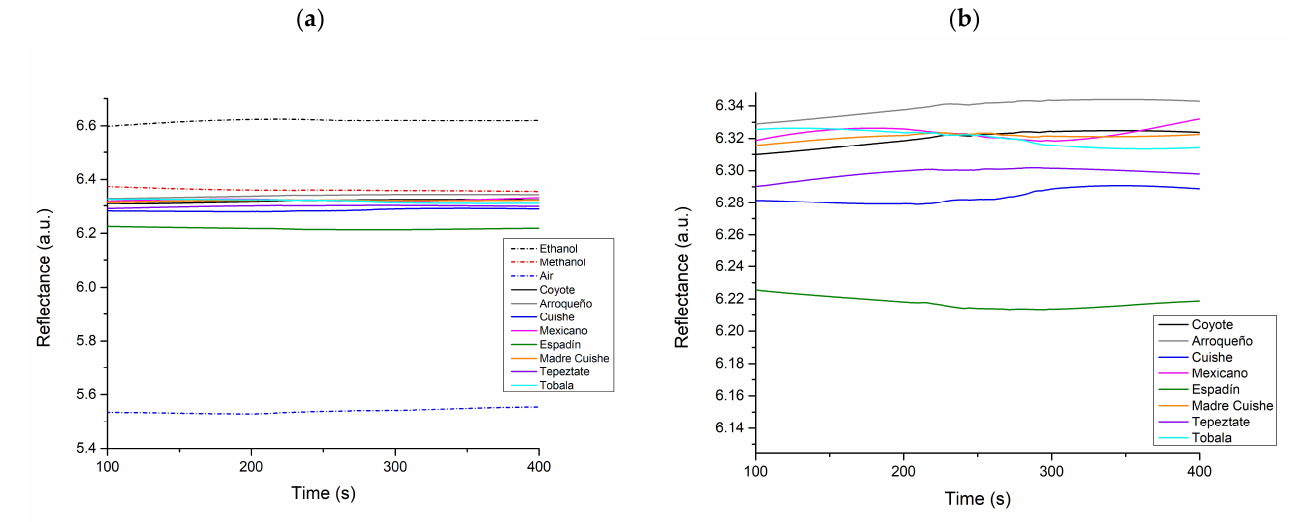
Figure 4. SPR measurements at a fixed angle: ( a ) mezcal samples and reference solutions (methanol, ethanol, and air) and ( b ) zoom of the SPR response region of mezcals.